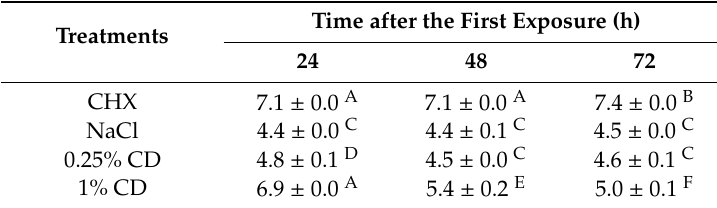
CHX: 0.12% chlorhexidine solution (positive control); NaCl: saline solution (negative control); 0.25%